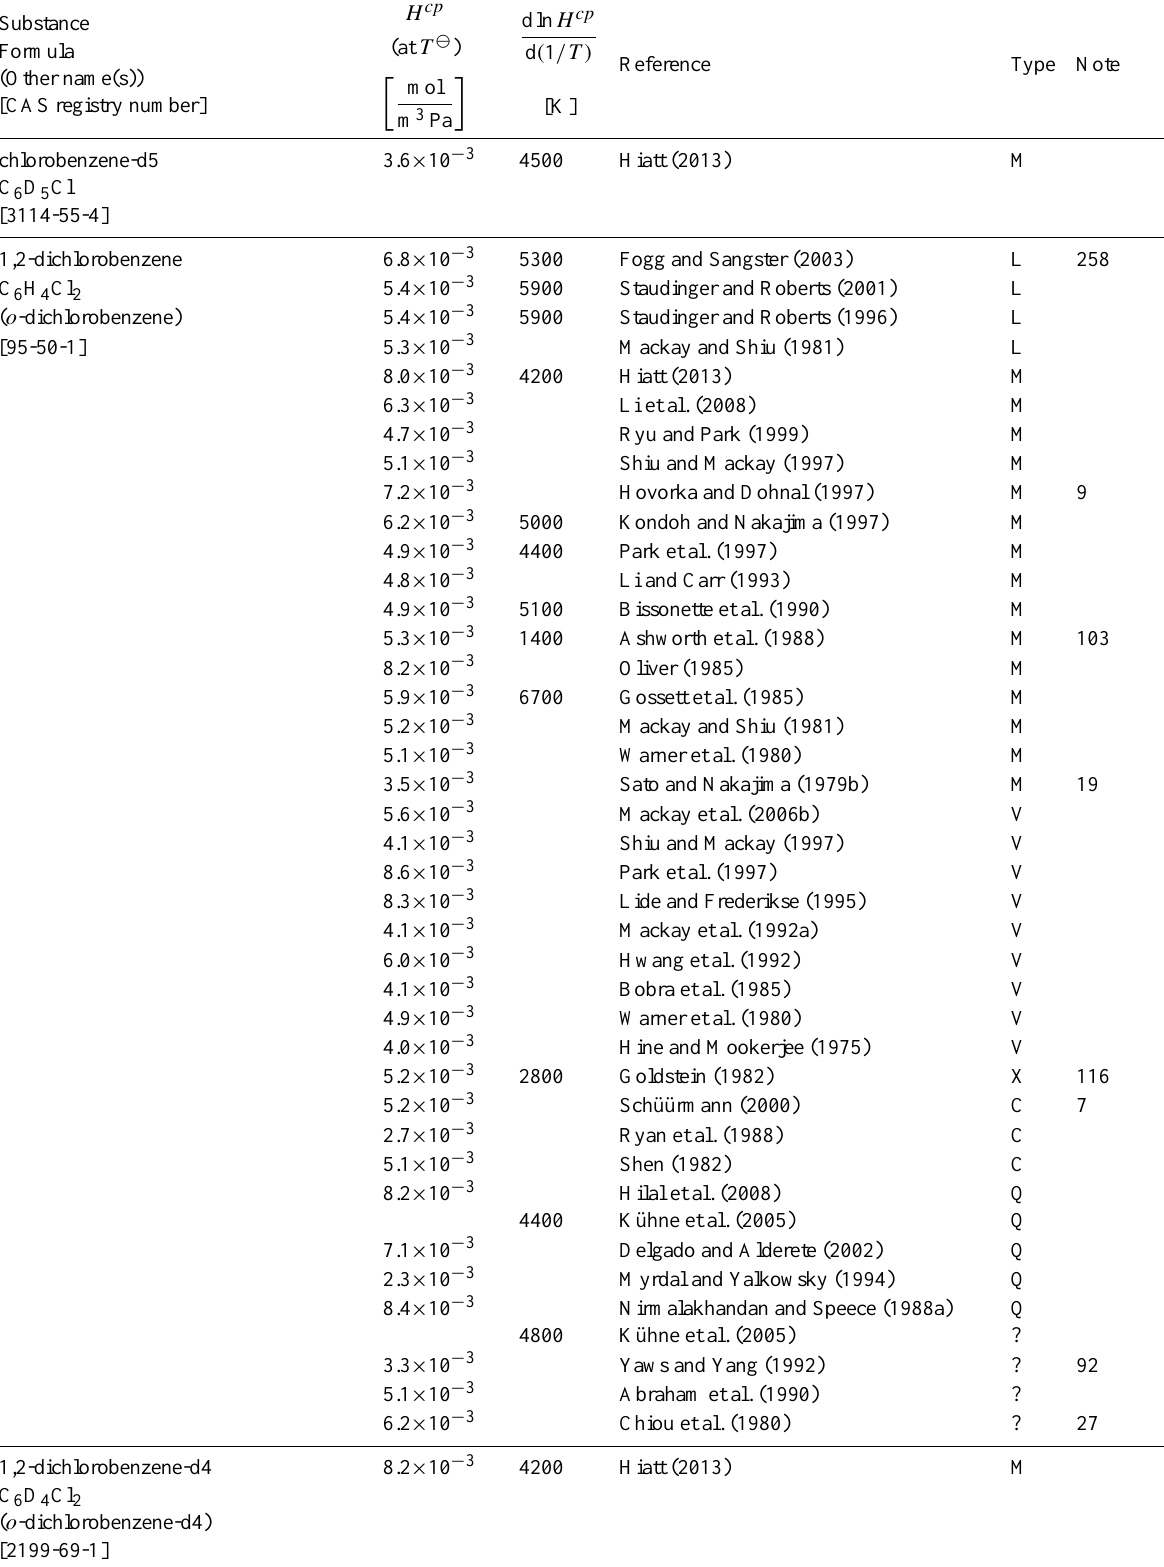
Table 6: Henry’s law constants for water as solvent